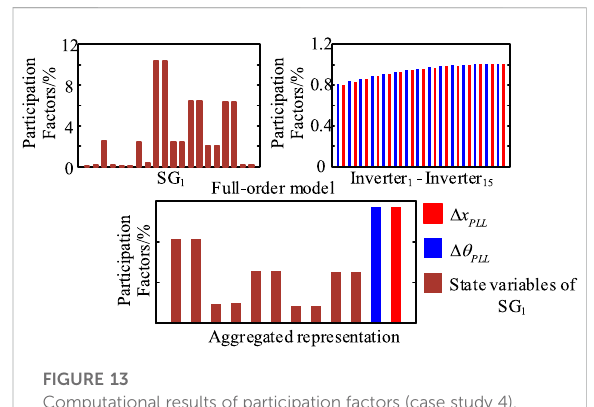
FIGURE 13 Computational results of participation factors (case study